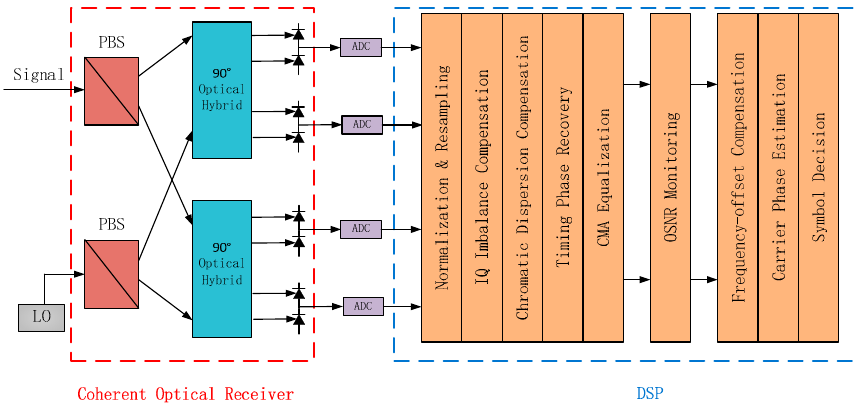
Figure 1. Schematic of the coherent optical receiver and digital signal processing (DSP) for optical signal-to-noise ratio (OSNR) monitoring (LO: local oscillator, PBS: polarization beam splitter, and ADC: analog-to-digital converter).